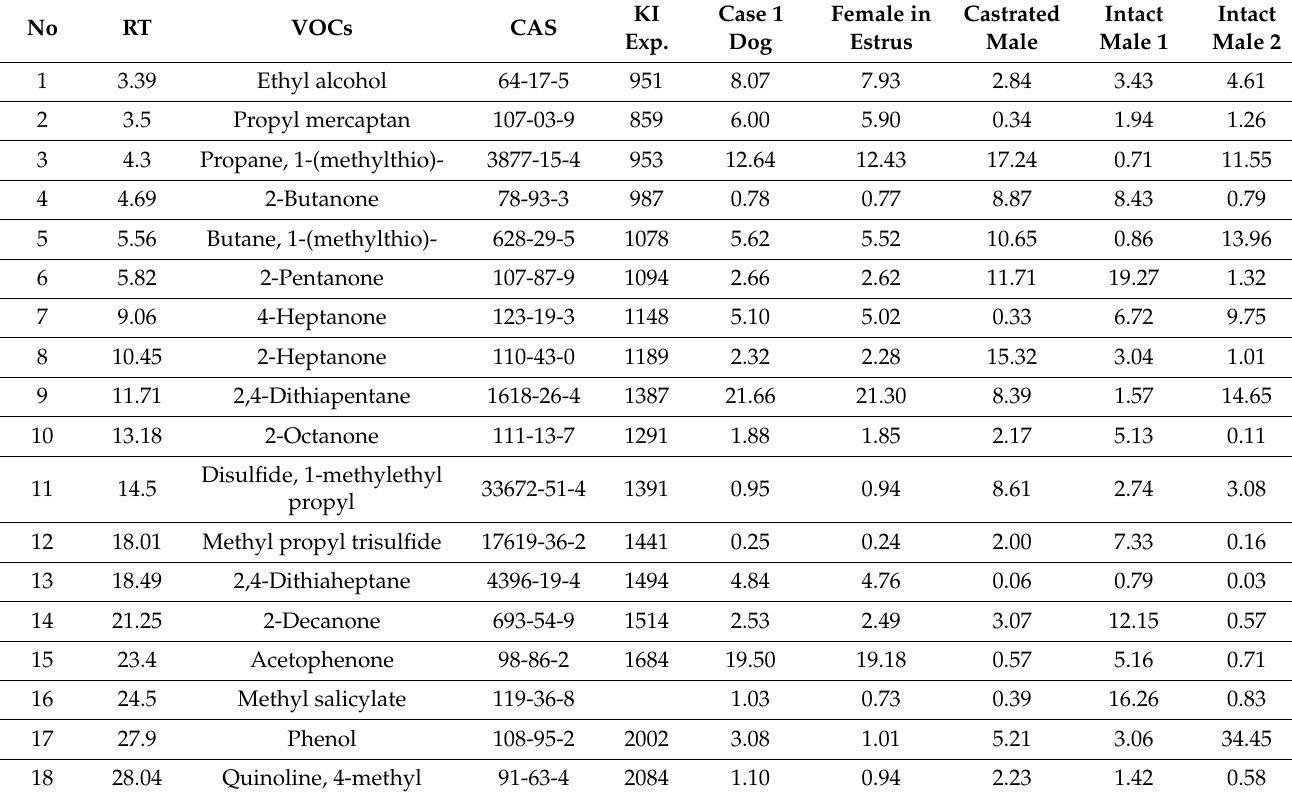
Table 1. Case 1. Profile of volatile organic compounds (VOCs) from various dog urine samples (in percentage of